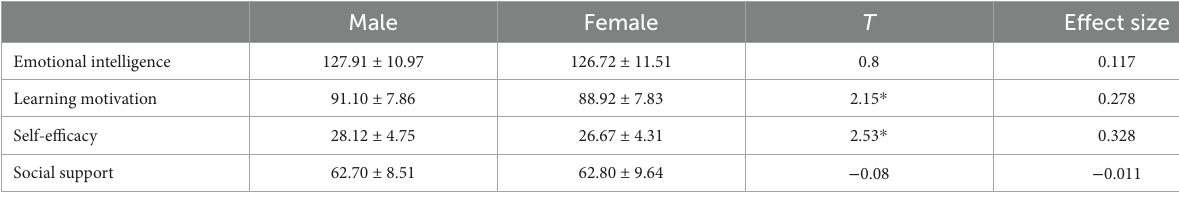
TABLE 4 Differences between the different gender groups.